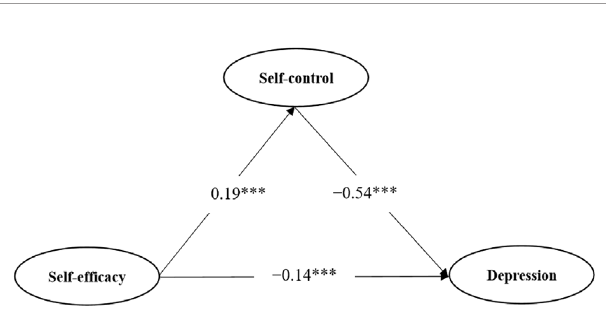
FIGURE 2 | Structural equation modeling of direct and mediating e ff ects on boxers ’ depression. ***indicates P < 0.001 and ***Statistically signi fi